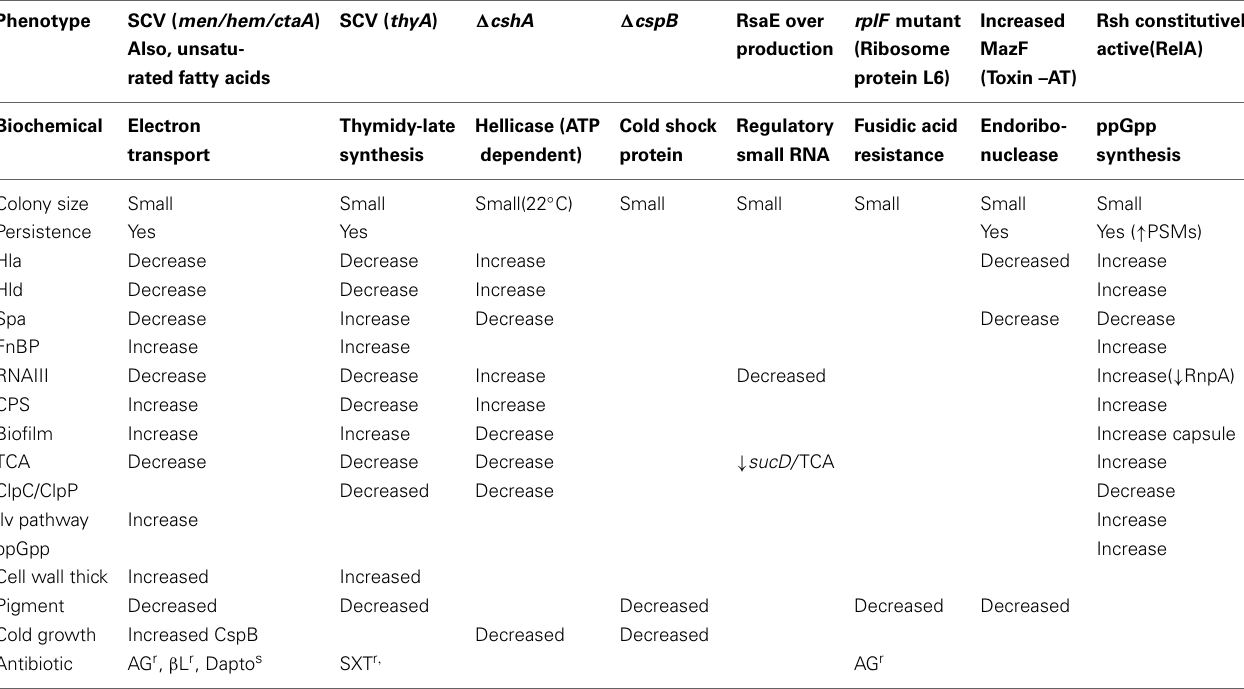
Table 2 | Comparison of phenotypes in SCVs and